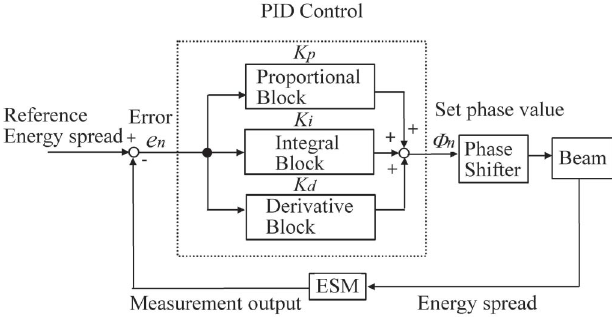
FIG. 3. Block diagram of the energy-spread feedback loop based on a PID